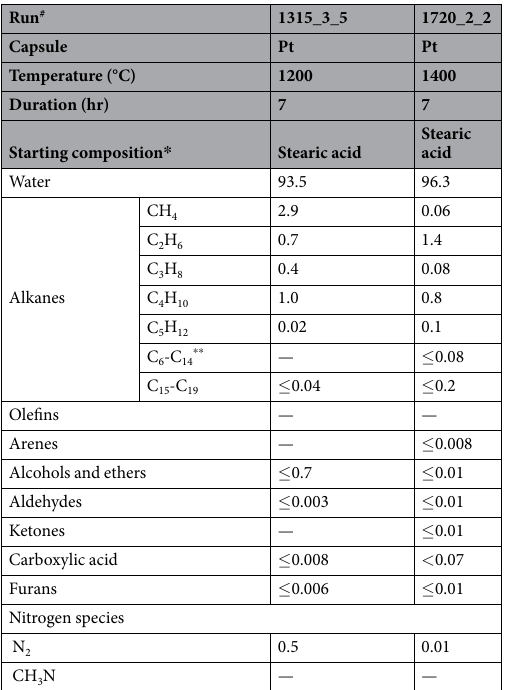
— — Table 6. Representative analyses of quenched H 2 O-rich C-O-H-N fluids (rel.%) obtained in unbuffered runs at 6.3 GPa. * All samples contained graphite. ** The quoted concentrations are maximum for a species of the respective group. All GC-MS data are given in Supplementary Table.